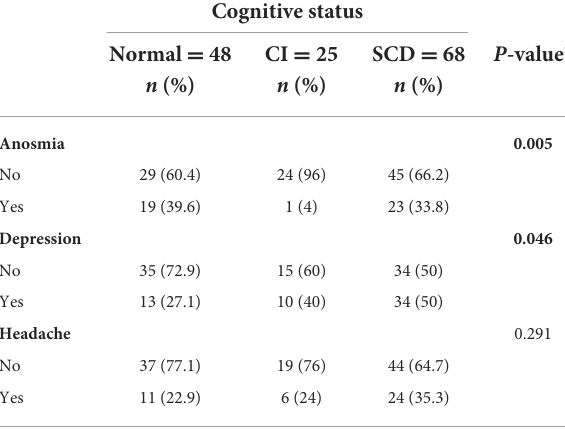
TABLE 6 Comparison between patients demographics and APOE genotype in relation to cognitive status.